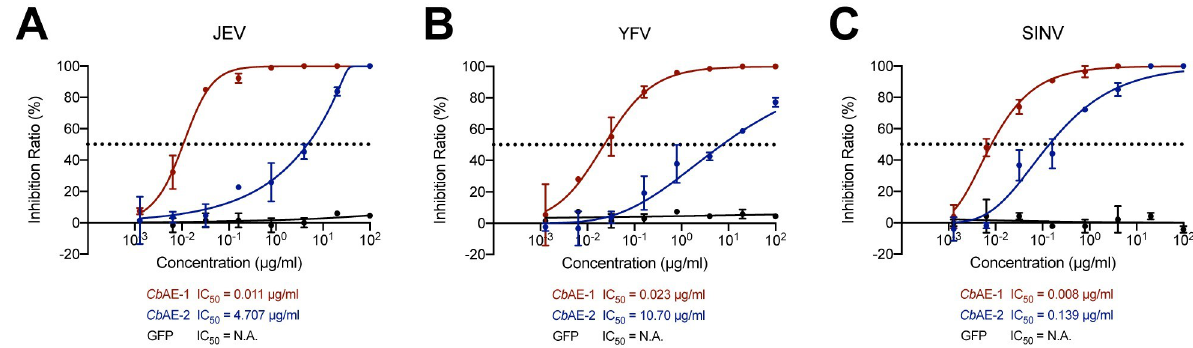
Fig 5. The virucidal activity of Cb AEs against JEV, YFV and SINV. (A-C) Inhibition curves of Cb AE-1 and Cb AE-2 against JEV (A), YFV (B), and SINV (C). Standard plaque reduction neutralization tests (PRNTs) were performed.